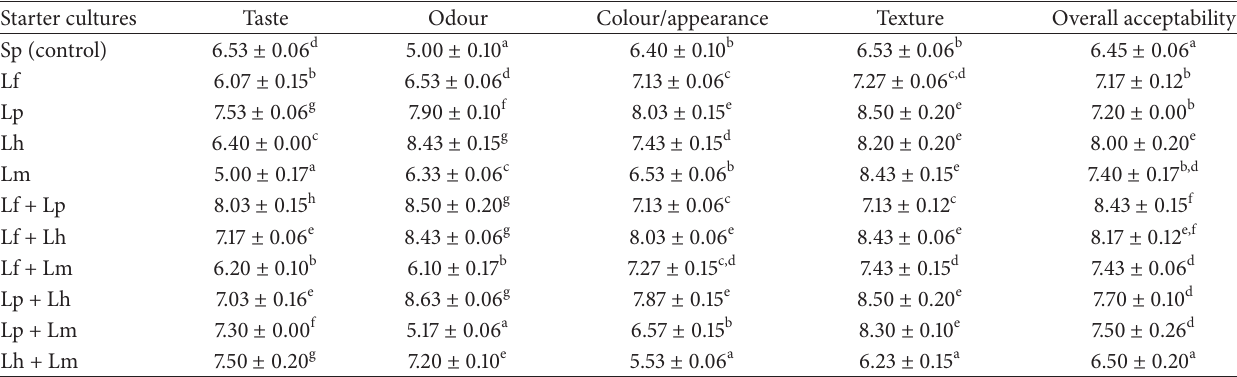
Table 5: Mean score of sensory attributes of Nunu prepared with various single and combined starter cultures. Evaluation is based on a nine-point hedonic